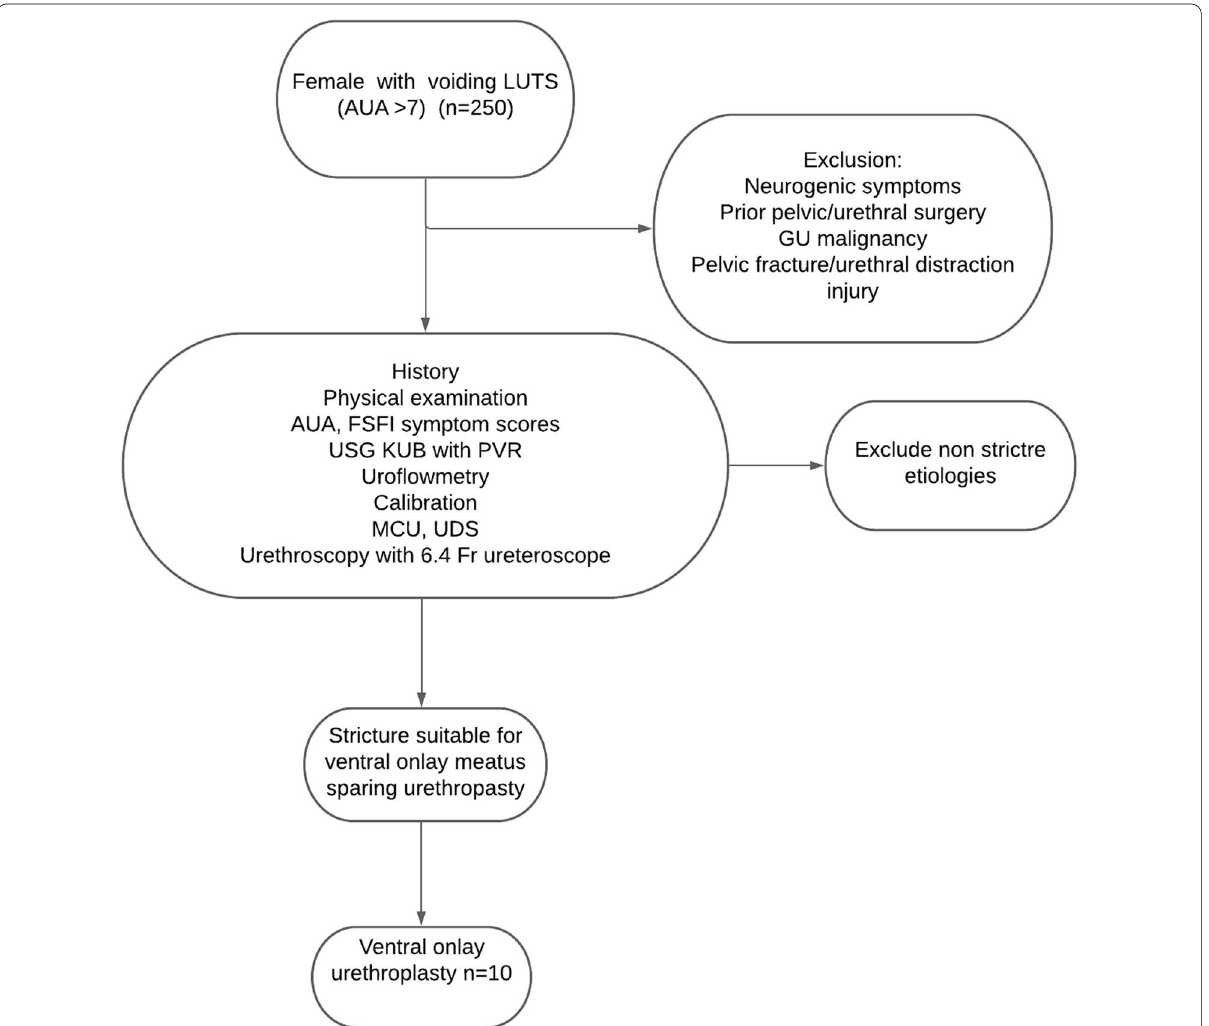
Fig. 1 Flow of the study. AUA (American Urology Association Symptom Score), FSFI (Female Sexual Function Index), SD (Standard Deviation), PVR (Post void residual volume), MCU(Micturating cystourethrogram), UDS (Urodynamic